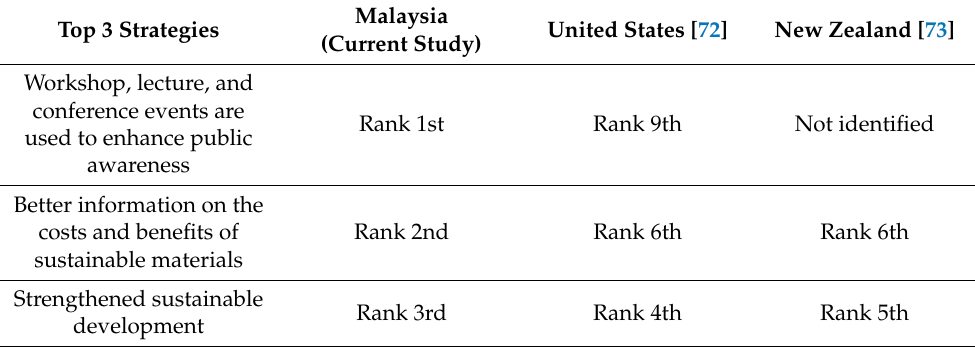
Table 5. Comparison of results with the United States and New Zealand. Top 3